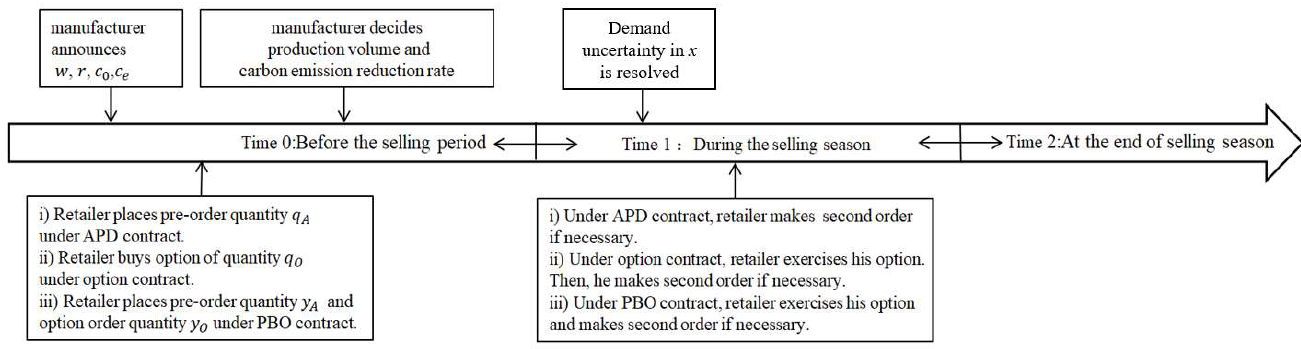
Figure 1. Sequence of events under